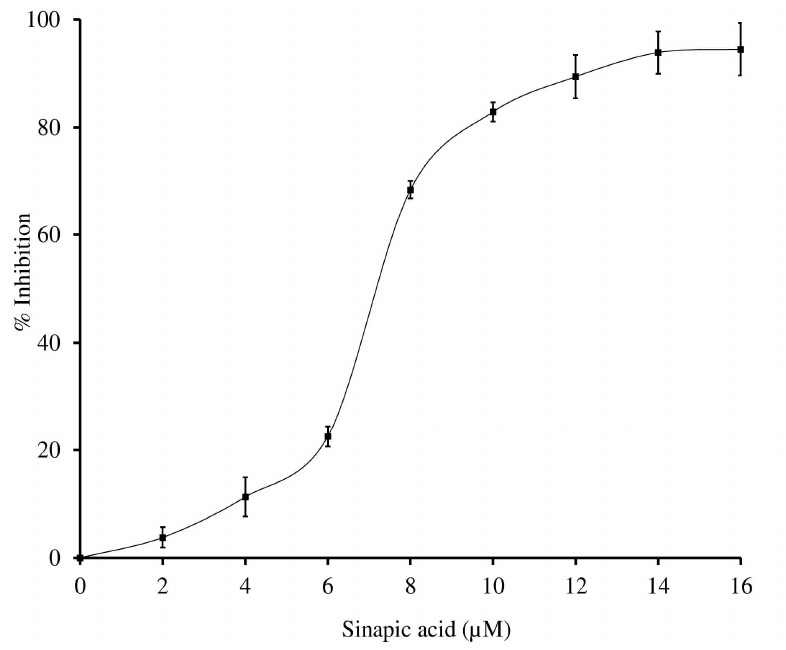
Figure 3. Inhibition of sPLA2-IIA enzyme by sinapic acid: sPLA2-IIA enzyme was incubated with sinapic acid (2–16 µM) at 37 °C for 60 min. Enzyme activity was measured by measuring the radiation of 14 C by liquid scintillation spectrometer. Enzyme inhibition was noted as a percentage of control. The data represents mean ± SD (n = 3). Table 3. IC 50 value of sinapic acid for sPLA 2 -IIA